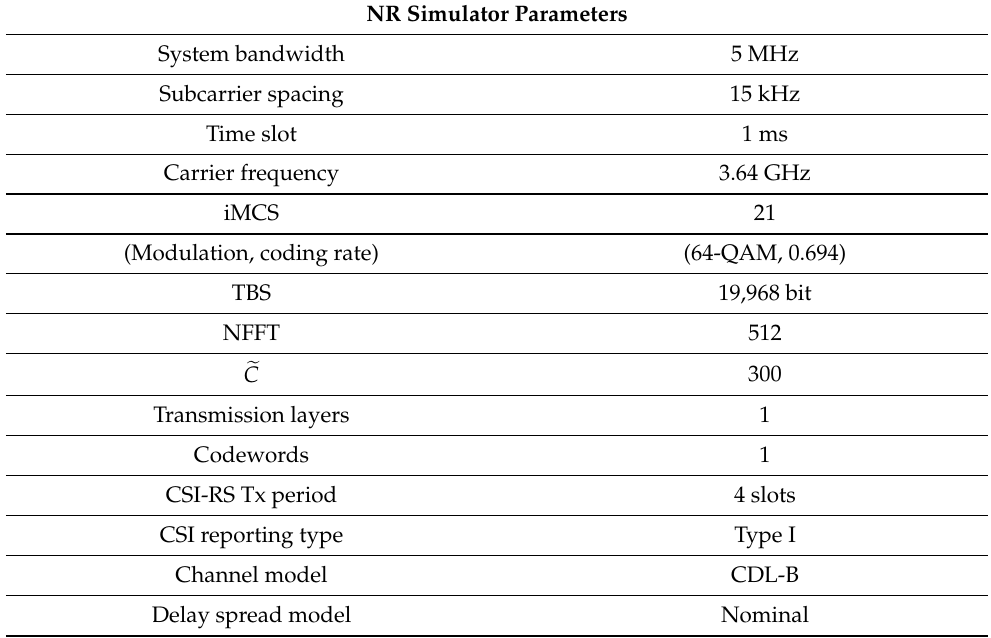
Table 1. Simulation parameters for NR-CsiNet